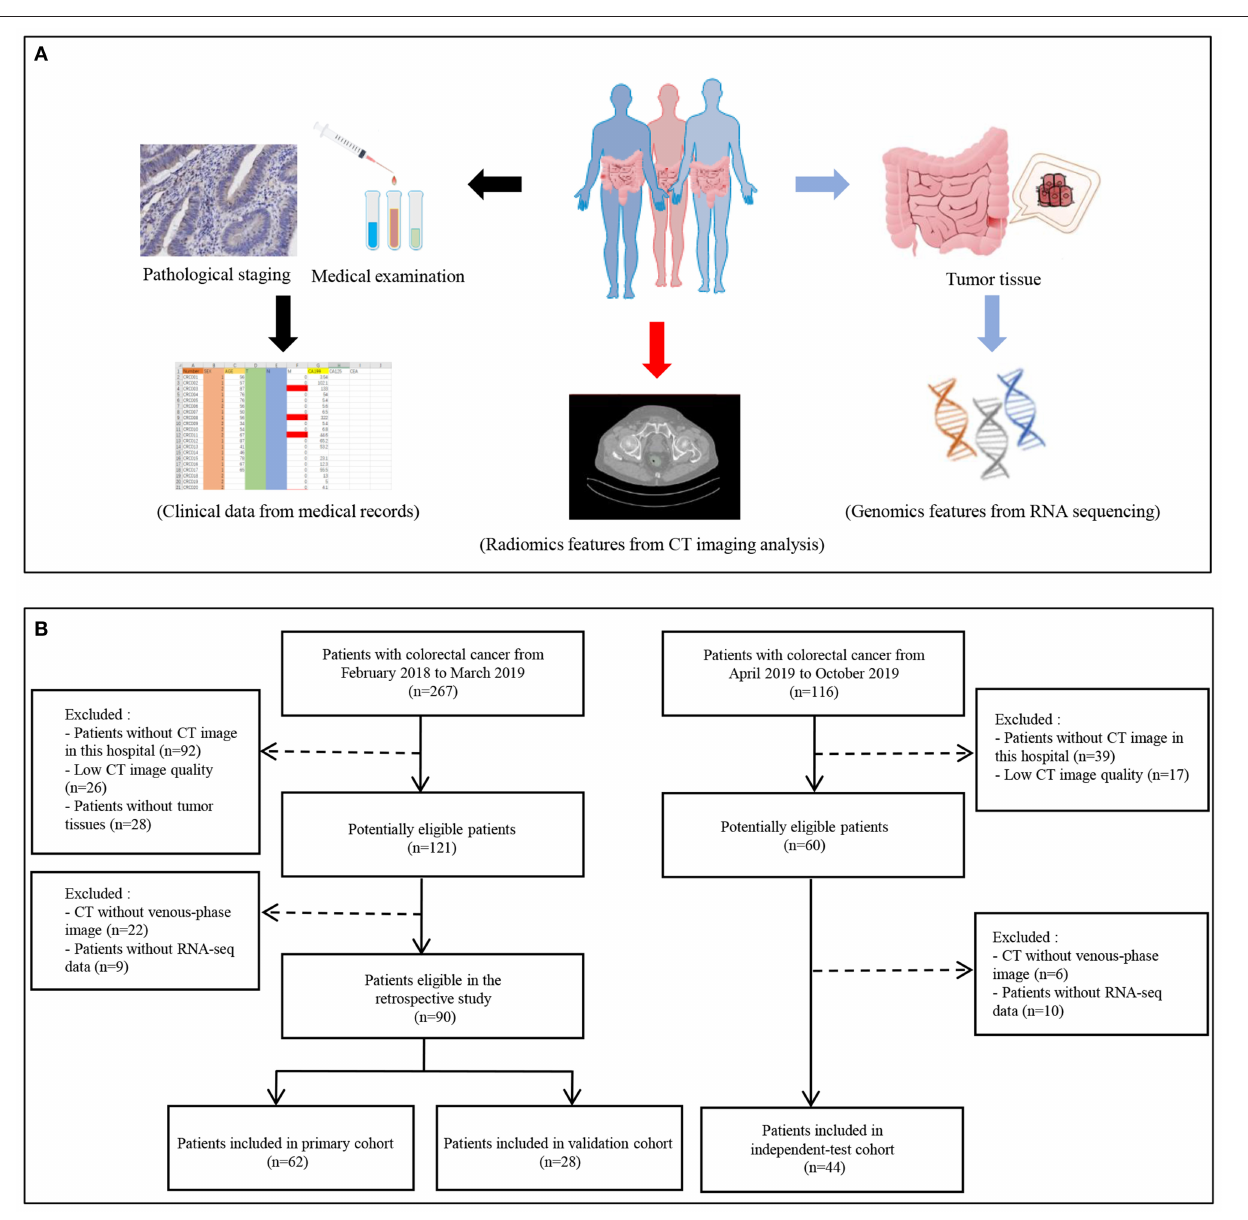
FIGURE 1 | Flowchart of study. (A) The data collection pipeline in this study. (B) Flowchart of patients’